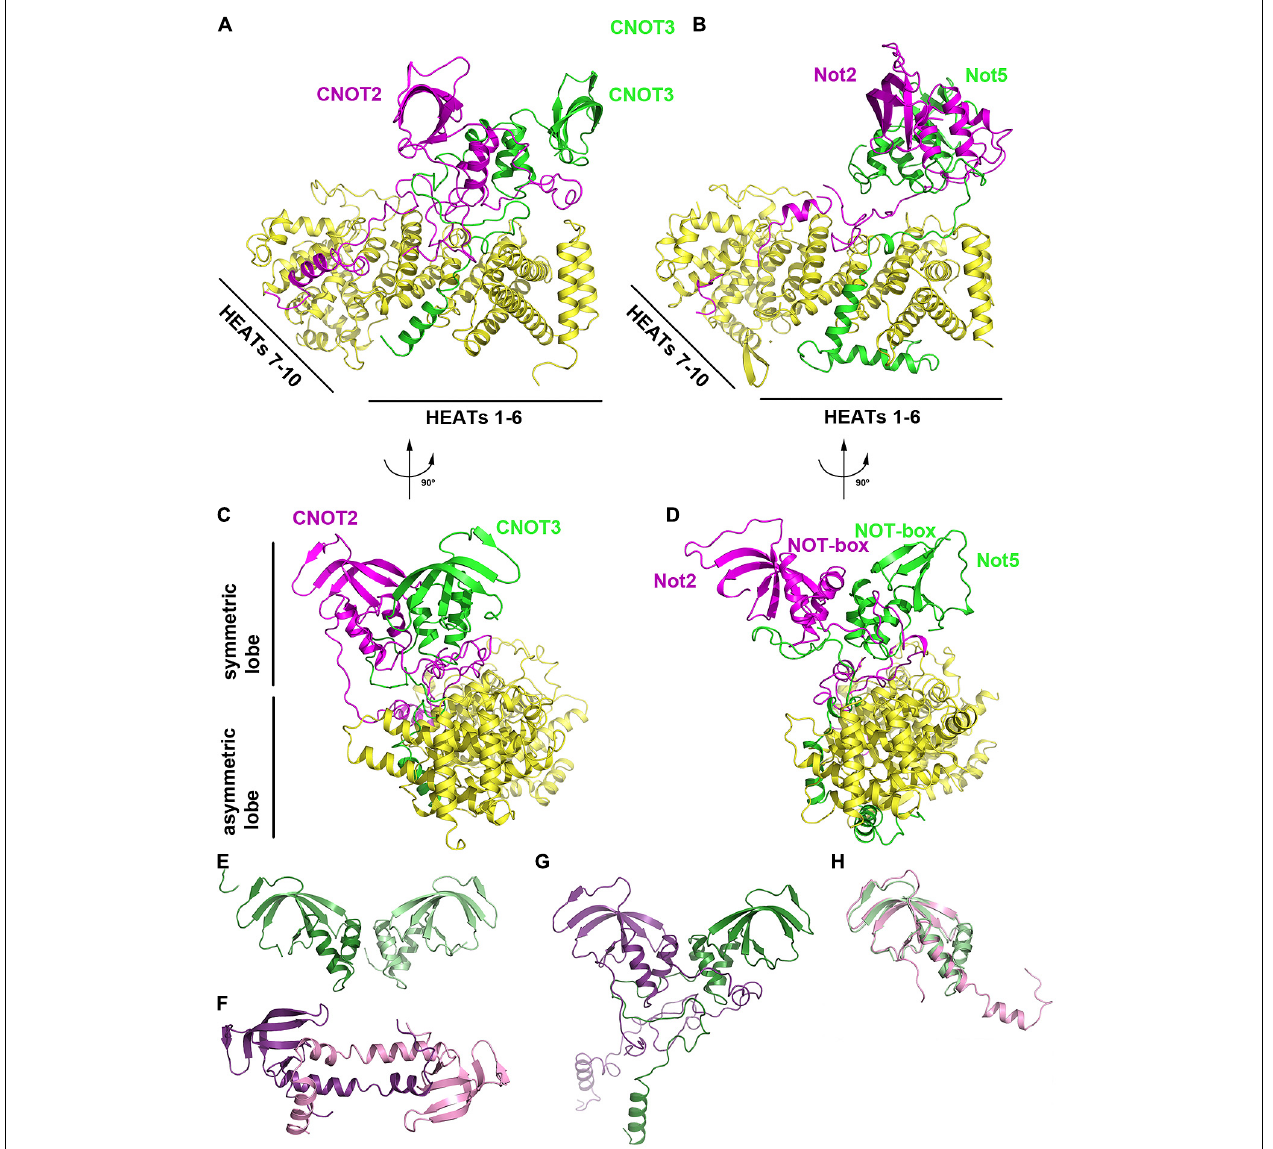
FIGURE 5 |The NOT module. (A) Crystal structure of the human CNOT1–CNOT2–CNOT3 ternary complex (PDB ID: 4C0D). CNOT1 is shown in yellow, CNOT2 in magenta and CNOT3 in green. (B) Crystal structure of the yeast Not1–Not2–Not5 ternary complex (PDB ID: 4BY6). Not1 is shown in yellow, Not2 in magenta and Not5 in green.The complex is shown in the same orientation as (A) . (C) View of the human CNOT1–CNOT2–CNOT3 complex related by 90 ◦ to the orientation in (A) . (D) View of the human